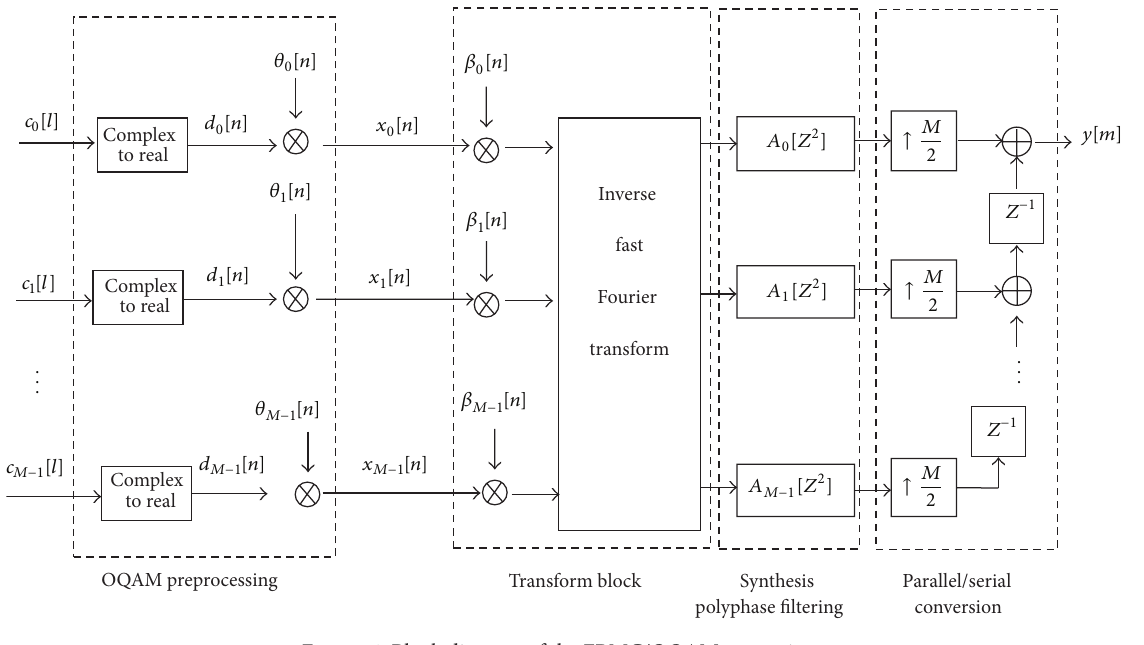
Figure 1: Block diagram of the FBMC/OQAM transmitter.